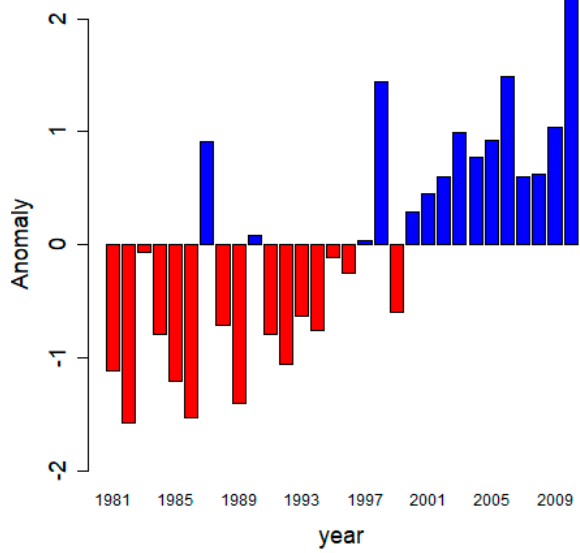
Figure 9. Anomaly of mean annual temperature in Mono watershed.